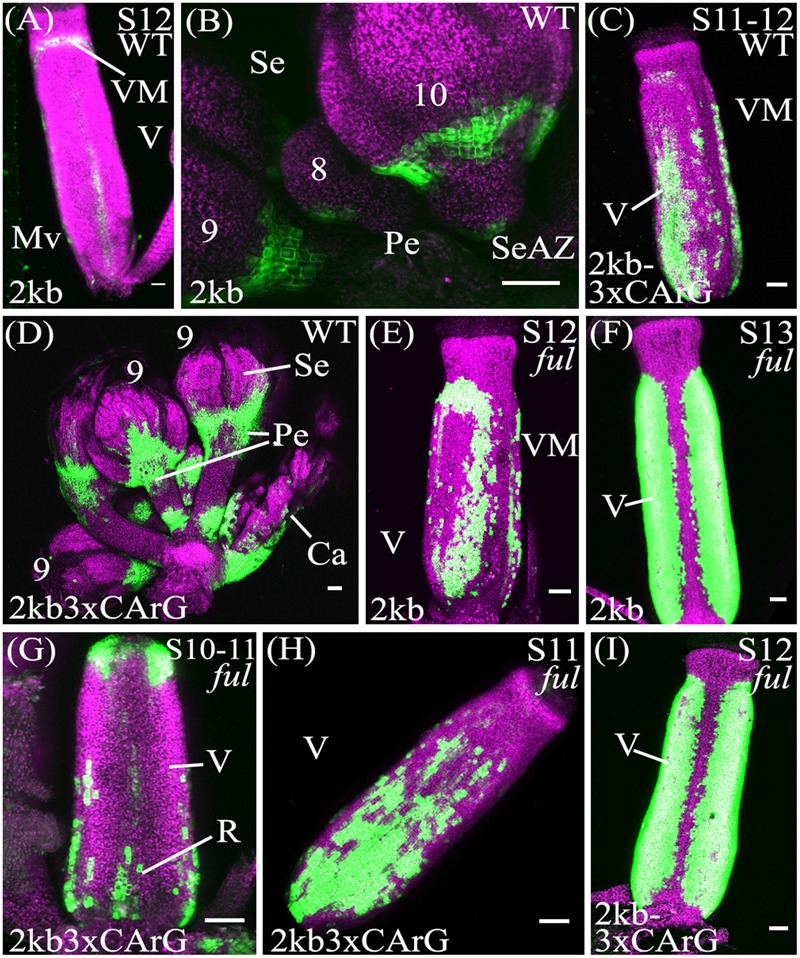
Mutation of CArG boxes within SHP2 regulatory regions causes a moderate de-repression of SHP2 expression within the valve, but mutated reporters remain FUL-responsive. Confocal microscope images (maximum intensity projections) of transgenic lines expressing GAL4/pUAS::YFP fusions. (A,B): pSHP22kb; (C,D): pSHP22kb-3XmCArG; (E,F): pSHP22kb in ful-2; (G,I): pSHP22kb-3XmCArG in ful-2. 2kb = pSHP22kb; WT = Col-0 genetic background; ful = ful-2 mutant background; 2kb3xCArG = pSHP22kb-3XmCArG; VM, valve margin; V, valve; st, style; Mv, midline valve; Se, sepal; SeAZ, sepal abscission zone; pe, pedicel. (A) Stage 12 pSHP22kb, basal midline valve expression; (B) Flowers (left to right: stage 9, 8, 10) pSHP22kb, expression in sepal AZ; (C) Stage 11-12 pSHP22kb-3XmCArG, basal valve; (D) Young flowers (6–9) pSHP22kb-3xmCArG, basal sepal, sepal-AZ, pedicel expression; (G) Gynoecium stage 10–11 pSHP22kb-3XmCArG in ful-2; (H) Stage 11 pSHP22kb-3XmCArG in ful-2, basal valve; (I) Stage 12 pSHP22kb-3XmCArG in ful-2. Scale bars represent 50 μm.